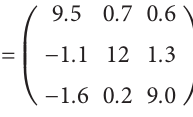
� 0 . 001 s and and x 22 22